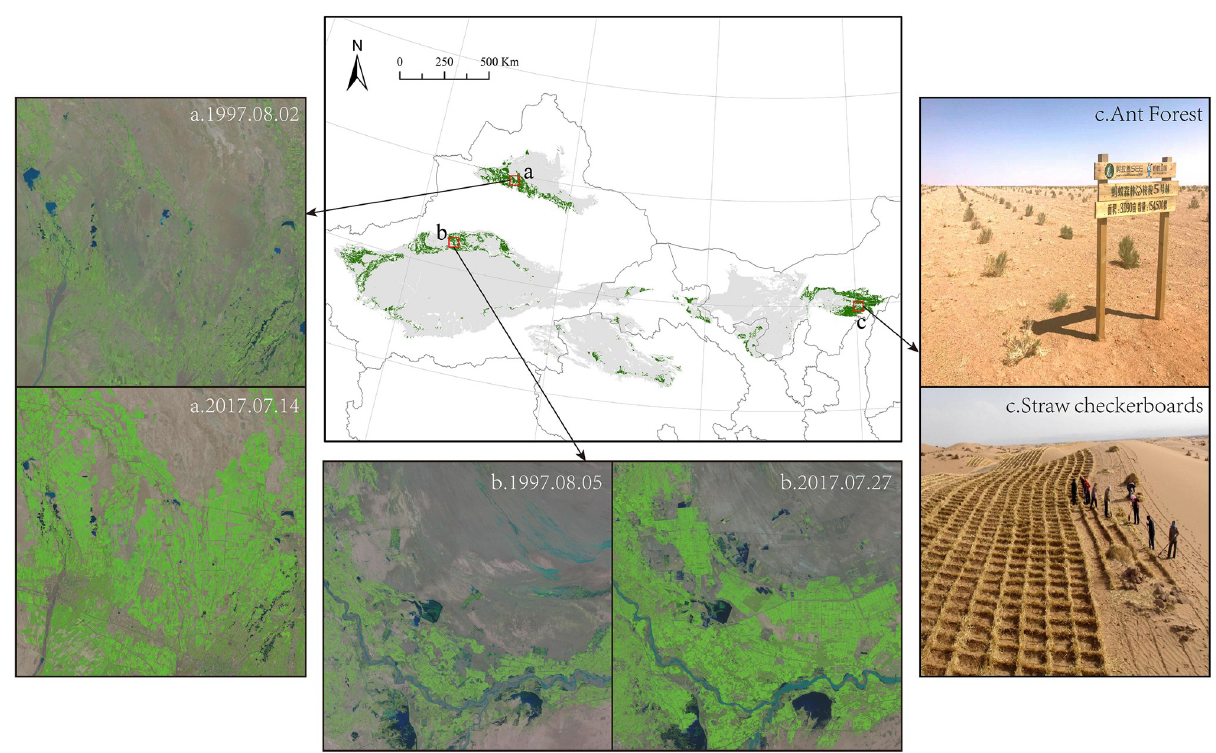
Fig 7. Greening regions caused by human activities. Green areas denote desert regions where greening trends were influenced by human activities.